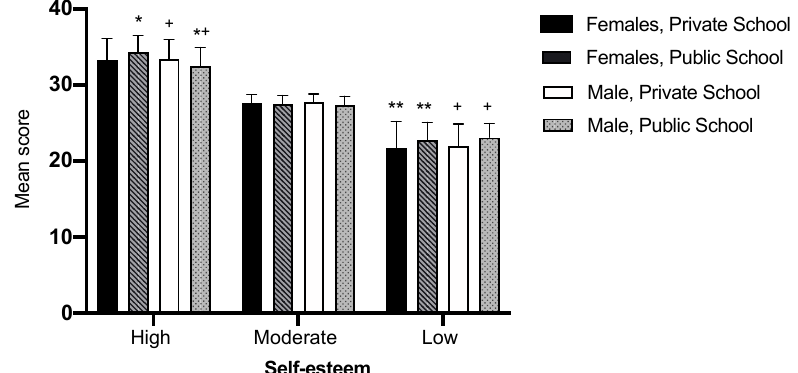
Figure 1. Level of self-esteem, mean and standard deviation, by sex and school type. *— p < 0.05 statistically significant difference between sexes; +— p < 0.05 statistically significant difference between schools, for males; **— p < 0.05 statistically significant difference between schools, for females.